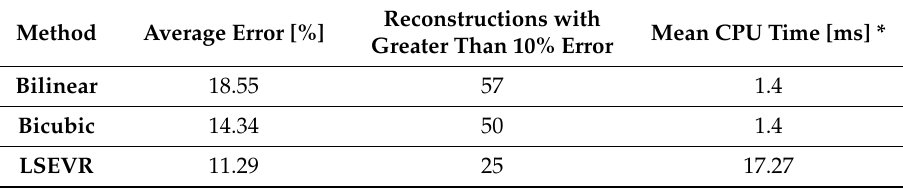
Table 2. Summary of comparative performance metrics. * CPU time includes time for ‘a’ matrix generation and velocity estimate.